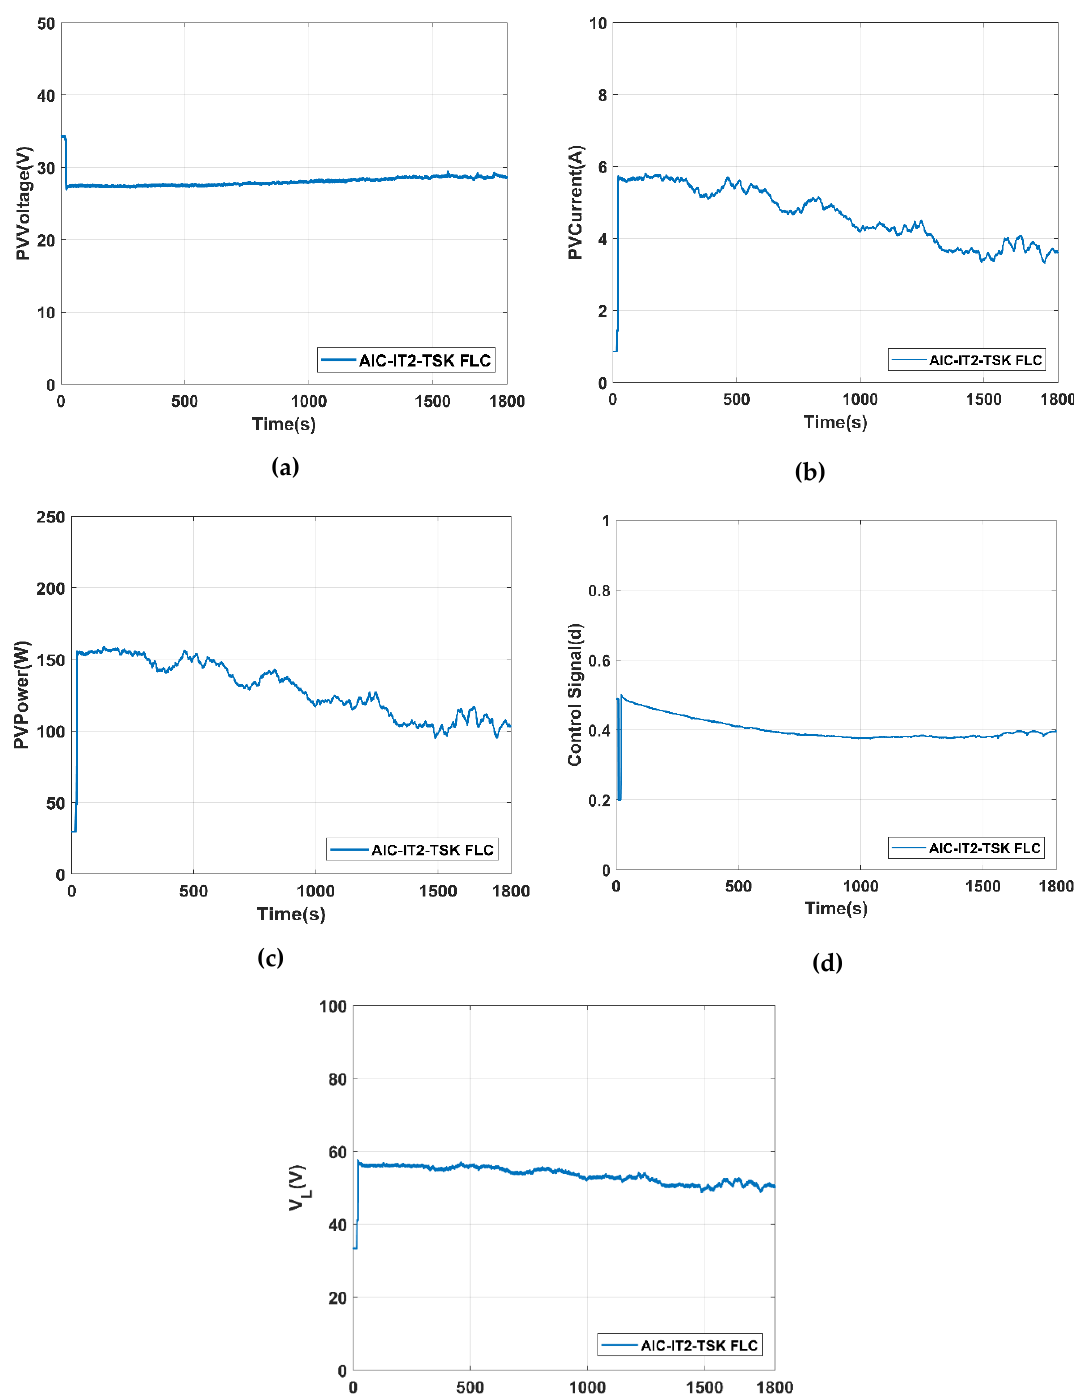
Figure 16. Experimental results of voltage ( a ), current ( b ) and power ( c ) of PV panel and control signal of AIC-IT2-TSK-FLC ( d ), output voltage of DC-DC converter ( e ).